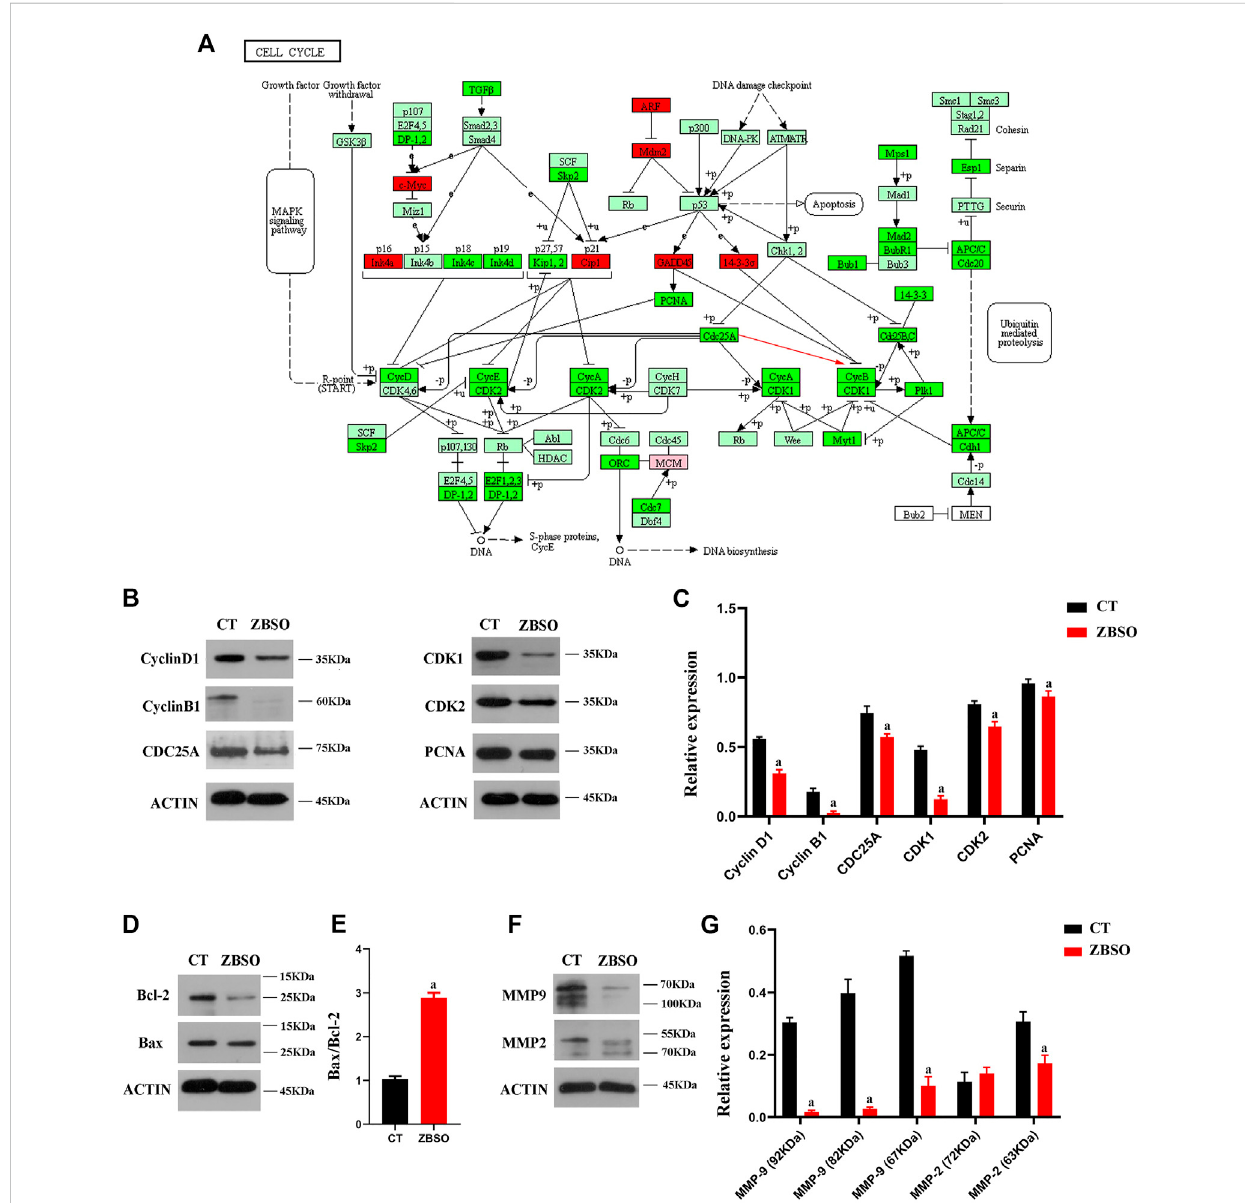
FIGURE 1 Cell cycle pathways of gene enrichment as well as gene and protein expression in human malignant melanoma A375 cells following treatment with ZBSO. (A) Cellcyclepathwaysofgeneenrichment,colorrepresentsvariationsingeneexpression,withlightgreenindicatingnodifference,redindicating upregulation, and bright green indicating downregulation. (B – G) Protein expression was measured using Western blot after 24 h of treatment of A375 cells with 0.45% ZBSO. The data in the graph are from the mean ± standard deviation of three independent experiments ( a p < 0.05 compared with control